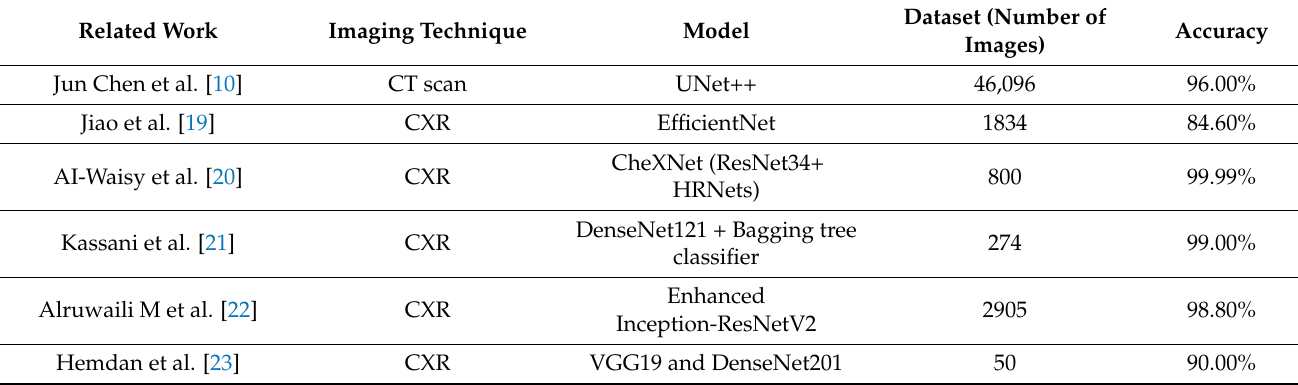
Table 3. Comparative study of proposed and previous